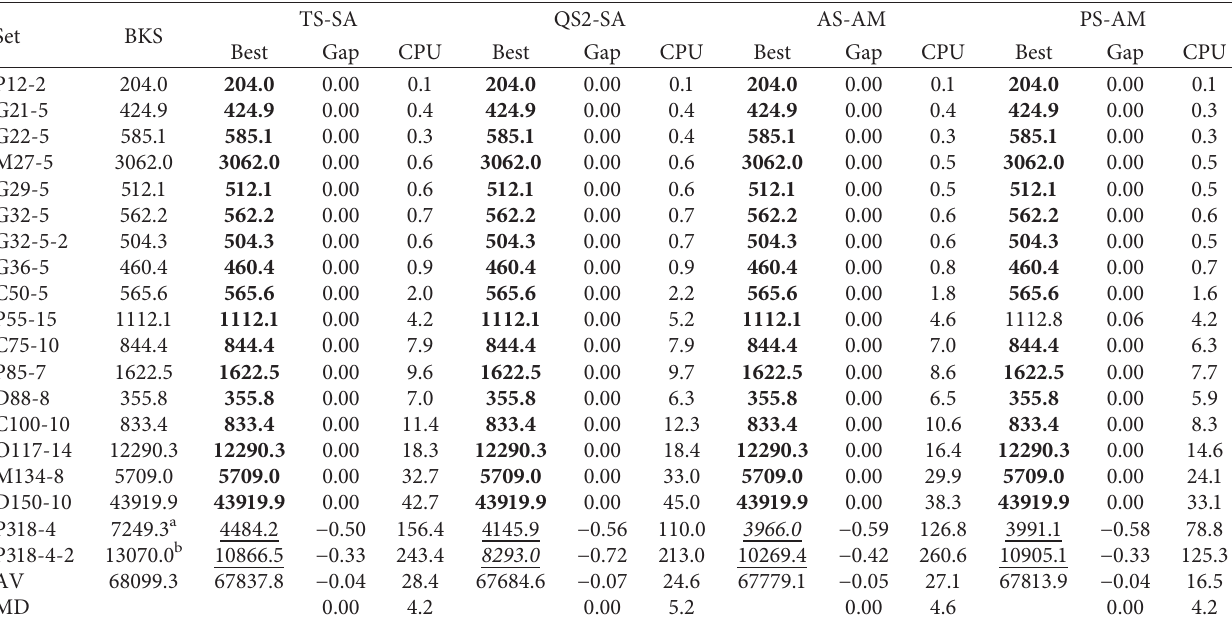
Figure 2: Box plots of scores for a statistical comparison of (a) selection strategies and (b) acceptance criteria. Table 4: Results for the CLRP instances in Barreto